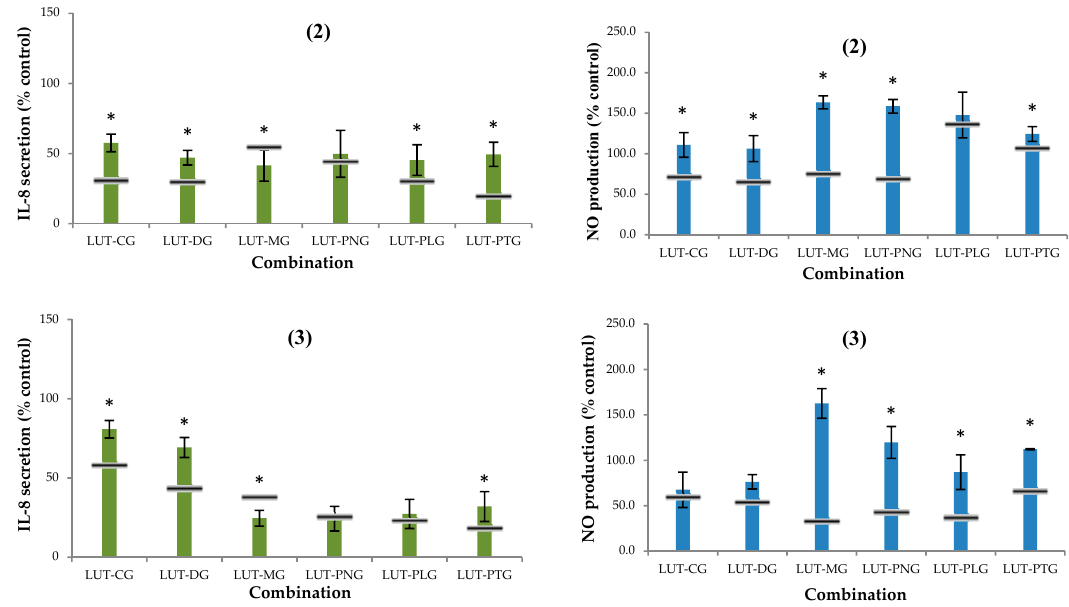
Figure 3. Secretion of ( A ) IL-8 (% control) and ( B ) nitric oxide (NO) (% control) by Caco-2 cells after being treated with different lutein-anthocyanin mixtures followed by TNF- α -induced inflammation (100 ng/mL). Total concentration of the bioactive compounds in cell culture was 10 μ M and the ratio of lutein to anthocyanin was varied at (1) 1:3, (2) 1:1, and (3) 3:1. Controls are samples collected from the cells that underwent TNF- α -induced inflammation without pre-treatment with phytochemicals. The horizontal lines illustrate the expected additive effect, which was calculated as 100 − (A + L − A × L/100) (A and L are % reduction of IL-8 or NO secreted by Caco-2 cells compared to the control when treating the cells with anthocyanin alone and lutein alone respectively). Asterisk-marked columns indicate a significant difference ( p < 0.05) between the observed effect of the combination with its calculated additive effect. Experimental values show as mean ± SD of three independent replicates. LUT: lutein, CG: kuromanin chloride, DG: myrtillin chloride, MG: oenin chloride, PNG: peonidin-3-glucoside chloride, PLG: callistephin chloride,